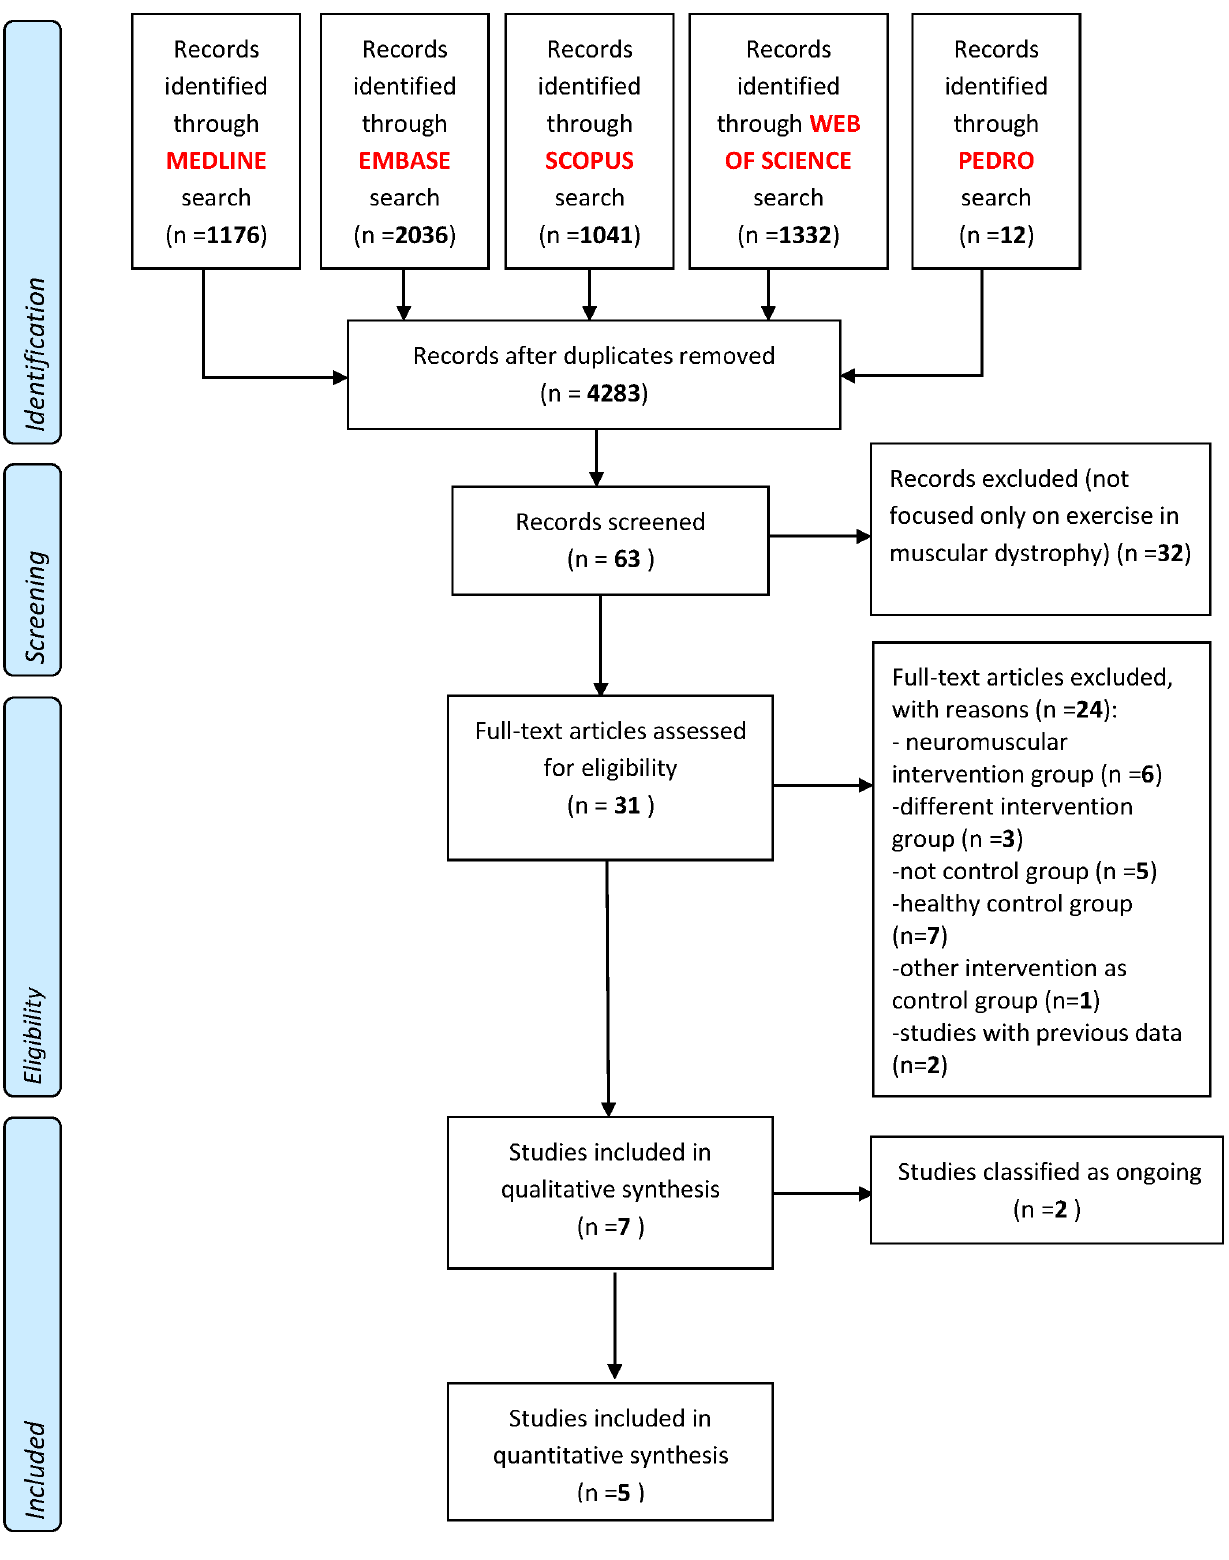
Figure 1. Literature flowchart.